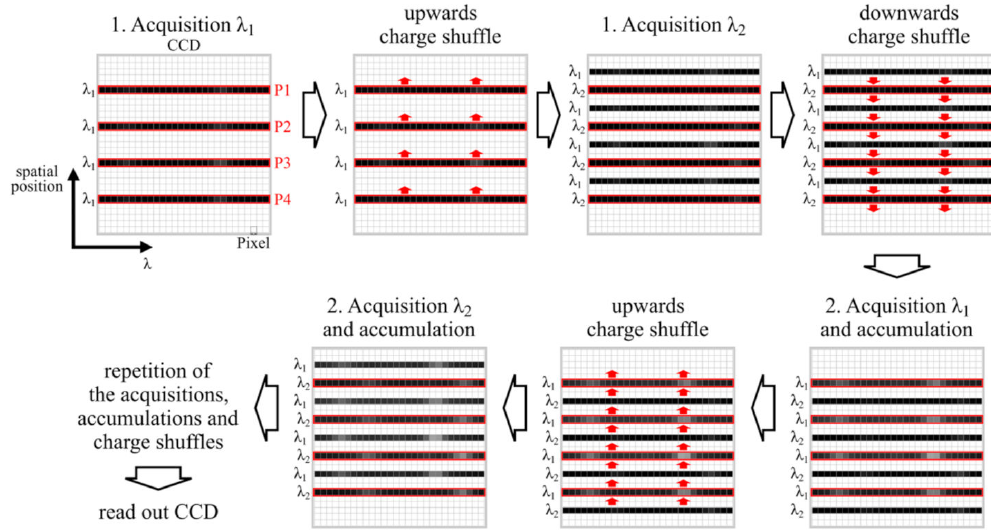
Figure 3. Illustration of the nod and shu ffl e technique by schematically showing the Charge-Coupled Device (CCD) chip (one square denotes one pixel on the CCD) and the shifting of charges (red arrows) after each acquisition and accumulation. The black lines symbolize the spectral signal traces with the corresponding excitation wavelengths to the left of them. The white spots inside the black lines display increasing signal strength, i.e., Raman bands that get more pronounced during the accumulation. The red boxes show the respective regions on the CCD, which are illuminated during the acquisition, where each box corresponds to the same spaxel (spatial Position P1, P2, P3, and P4) of the Raman image. For simplicity, only four spaxels of the Raman image are